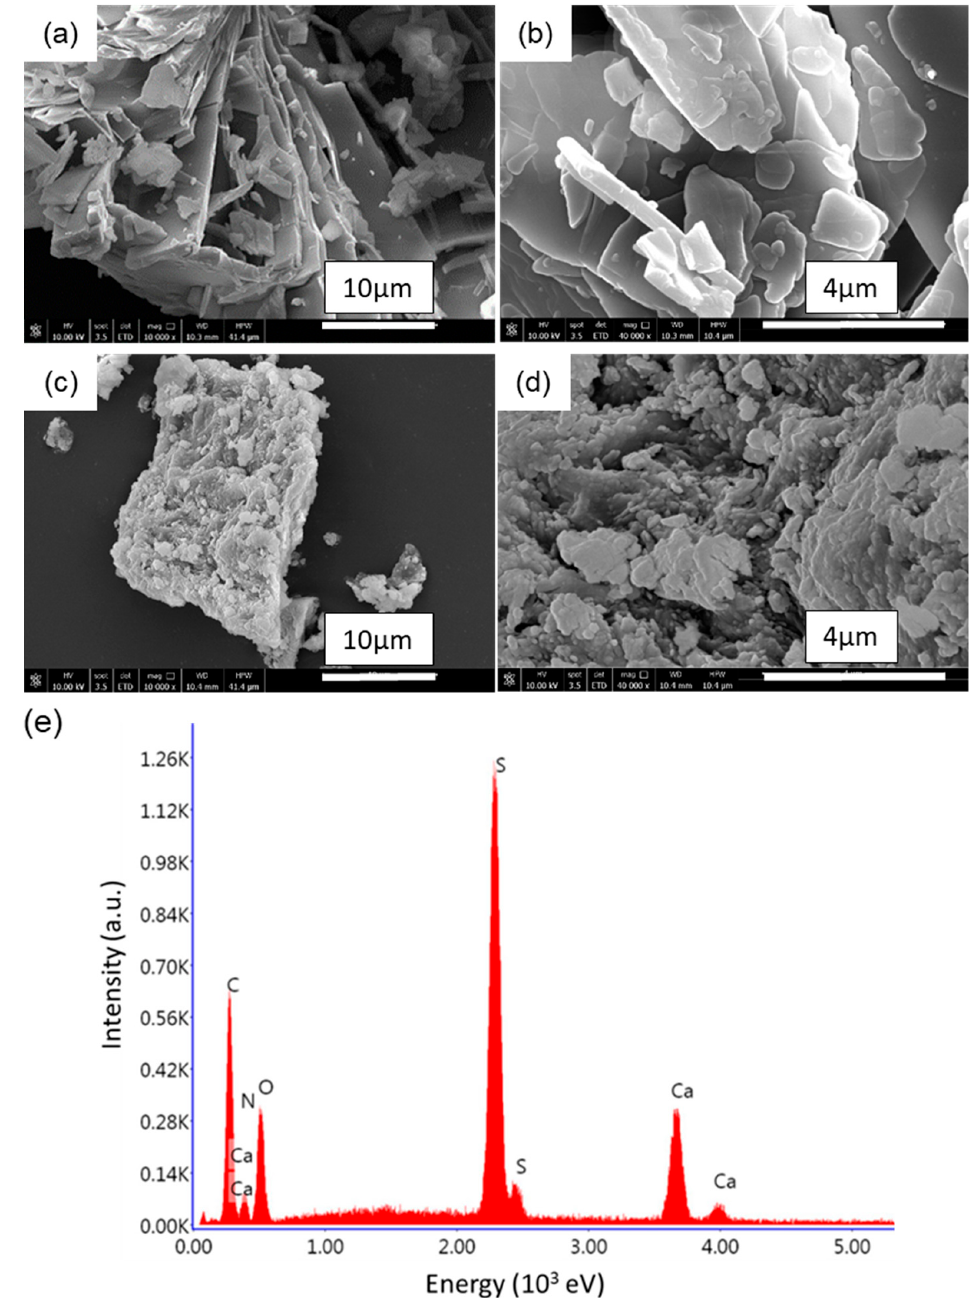
Figure 2. SEM micrographs of ( a , b ) Na 2 HS and ( c , d ) CaHS with ( e ) EDX Figure 2 . SEM micrographs of ( a , b ) Na 2 HS and ( c , d ) CaHS with ( e ) EDX spectrum.